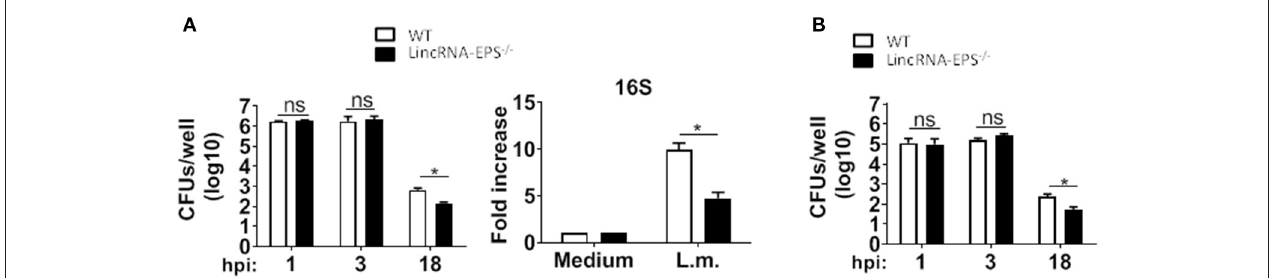
FIGURE 3 | LincRNA-EPS promotes L. monocytogenes replication in vitro . (A) CFU counts in WT and lincRNA-EPS − / − BMDMs after 18h of Listeria infection (MOI of 1) (left) and mRNA levels of bacterial 16S in WT and lincRNA-EPS − / − BMDMs after 6h of L. monocytogenes infection (MOI of 1) (right). (B) CFU counts in WT and